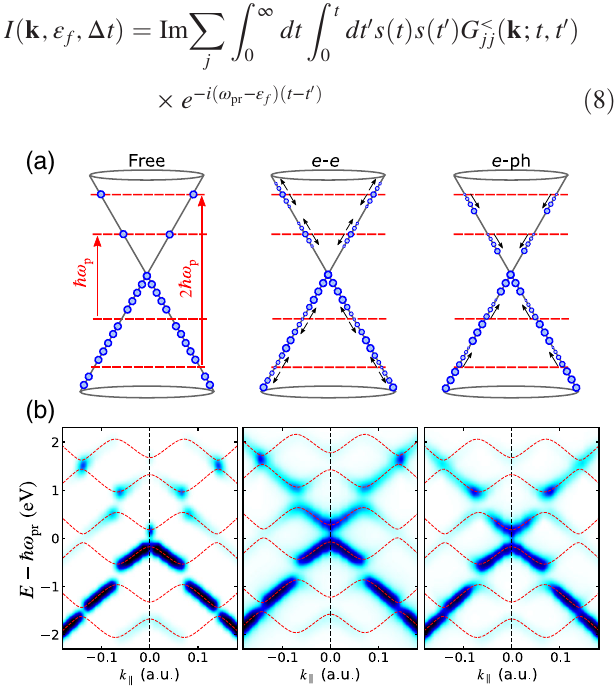
FIG. 3. (a) Illustration of the interplay between photoexcitation and scattering processes close to a Dirac point. (b) TR-ARPES spectra calculated with the simplified formula (8) with aligned pump ( E 0 ¼ 4 × 10 − 3 a : u : ) and probe pulse, for the free system (left), including only e - e (middle) and only e -ph scattering (right panel), respectively. The spectra are calculated along the path − μ is the kinetic energy shown in Fig. 2(a). The energy E ¼ ε f of the photoelectrons shifted by the chemical potential μ ¼ − 4 . 6 eV. The red dashed lines represent the band structure of the Floquet Hamiltonian